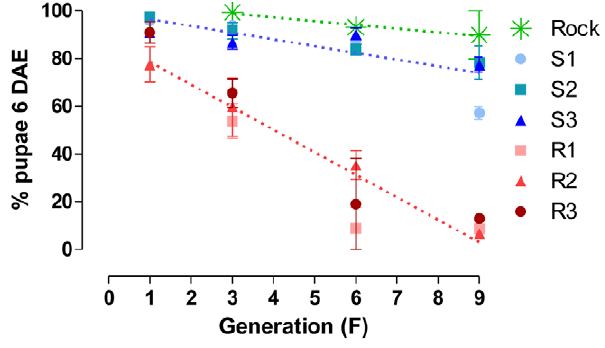
Figure 2. Time of larval development – selected lineages. Mean rate of pupa formation of an Aedes aegypti field population submitted to pyrethroid selection in the laboratory. Standard error is also indicated. Lines are regression at the 6 th day after larva hatching for pooled lineages of R (dotted red), S (dotted blue) and Rockefeller (dotted green). Values for linear regression analysis are: Rock ( b = 2 1.565, r2=0.285, p . 0.05), S ( b = 2 2.817, r2=0.6095, p , 0.0001) and R ( b = 2 9.434, r2=0.8217, p , 0.0001).